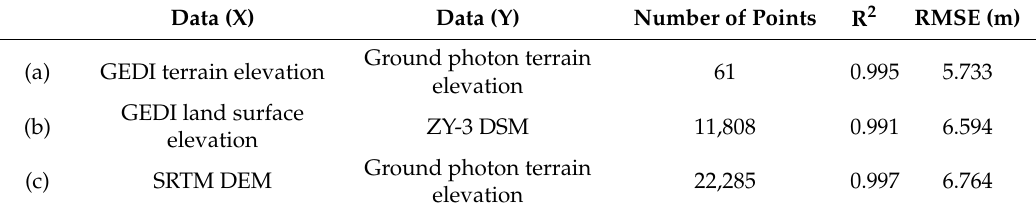
Figure 8. ZY-3 DSM masked by two forest area masks and score bands. Discontinuous CHM dataset calculated by DSM subtracting ground photon values. ( a , b ) shows the distribution of DSM, and ( c , d ) shows the distribution of discontinuous CHM dataset. Table 5. Statistical results of comparison of DSM and ground photon average height values with Table 4. Statistical table of forest canopy height in discontinuous CHM dataset. GEDI